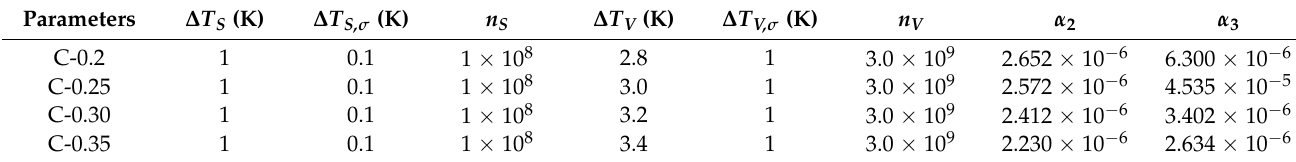
Table 6. Nucleation parameters of CAFE